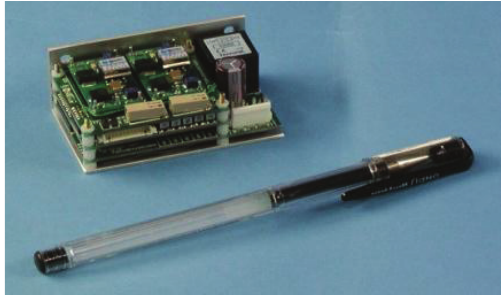
Figure 9: Servo driver used for WABIAN-2’s arm (TD12770- 48W05).